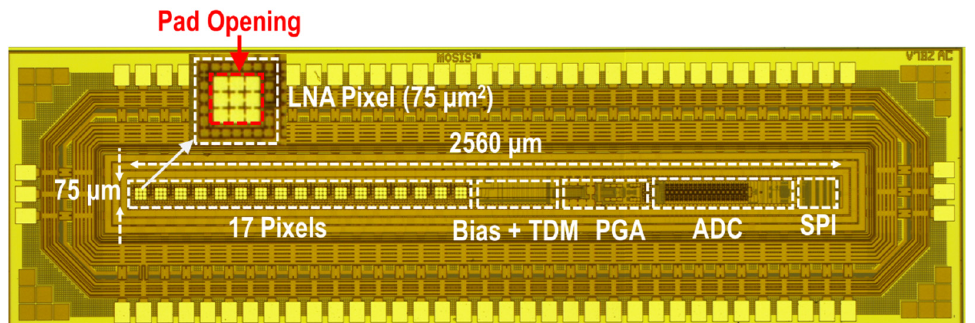
Figure 11. Die microphotograph of the fabricated 16-channel AC-coupled neural recording frontend.